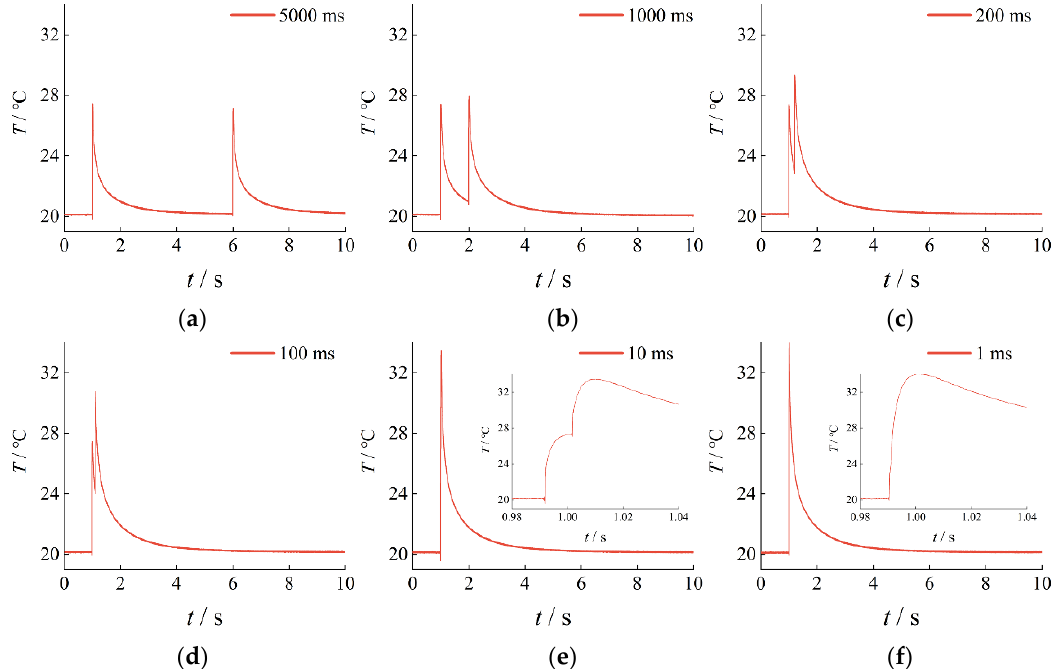
Figure 5. Thermocouple output response curves under double-pulse laser excitation over different time intervals: ( a ) Time interval = 5000 ms; ( b ) Time interval = 1000 ms; ( c ) Time interval = 200 ms; ( d ) Time interval = 100 ms; ( e ) Time interval = 10 ms; ( f ) Time interval = 1 ms.